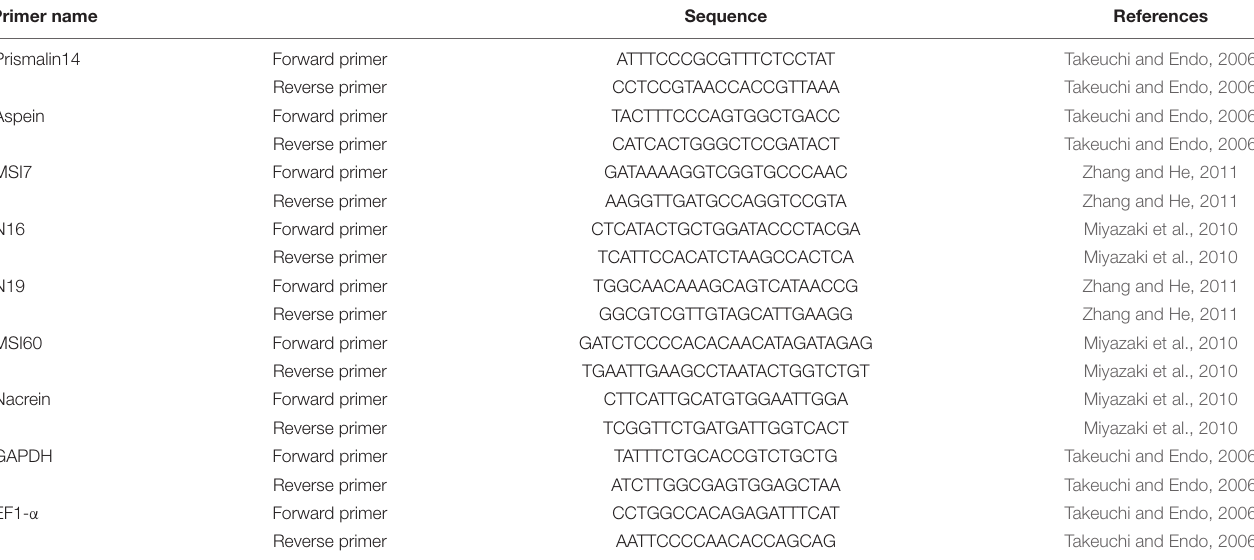
TABLE 1 | Nucleotide sequences of primers used in real-time